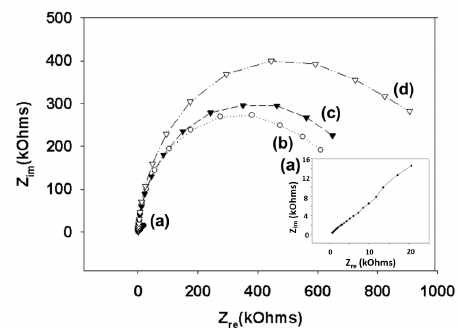
Figure 3. Nyquist diagram ( Z im vs. Z re ) for the Faradaic impedance measurement of a sensing chip in PBS (pH 7.4) containing 2 mM [Fe(CN) 6 ] 3 − /4 − over the course of the surface functionalization reaction. A gold electrode ( a ) was treated with 11-mercapto-1-undecanol ( b ), epichlorohydrin ( c ), and mucin ( d ). Impedance spectra were measured within the frequency ranging from 0.1 to 1000 Hz at the formal potential of the [Fe(CN) 6 ] 3 − /4 − redox couple. The amplitude of the alternative voltage was 5 mV. The inset shows an enlarged plot for a bare gold electrode.